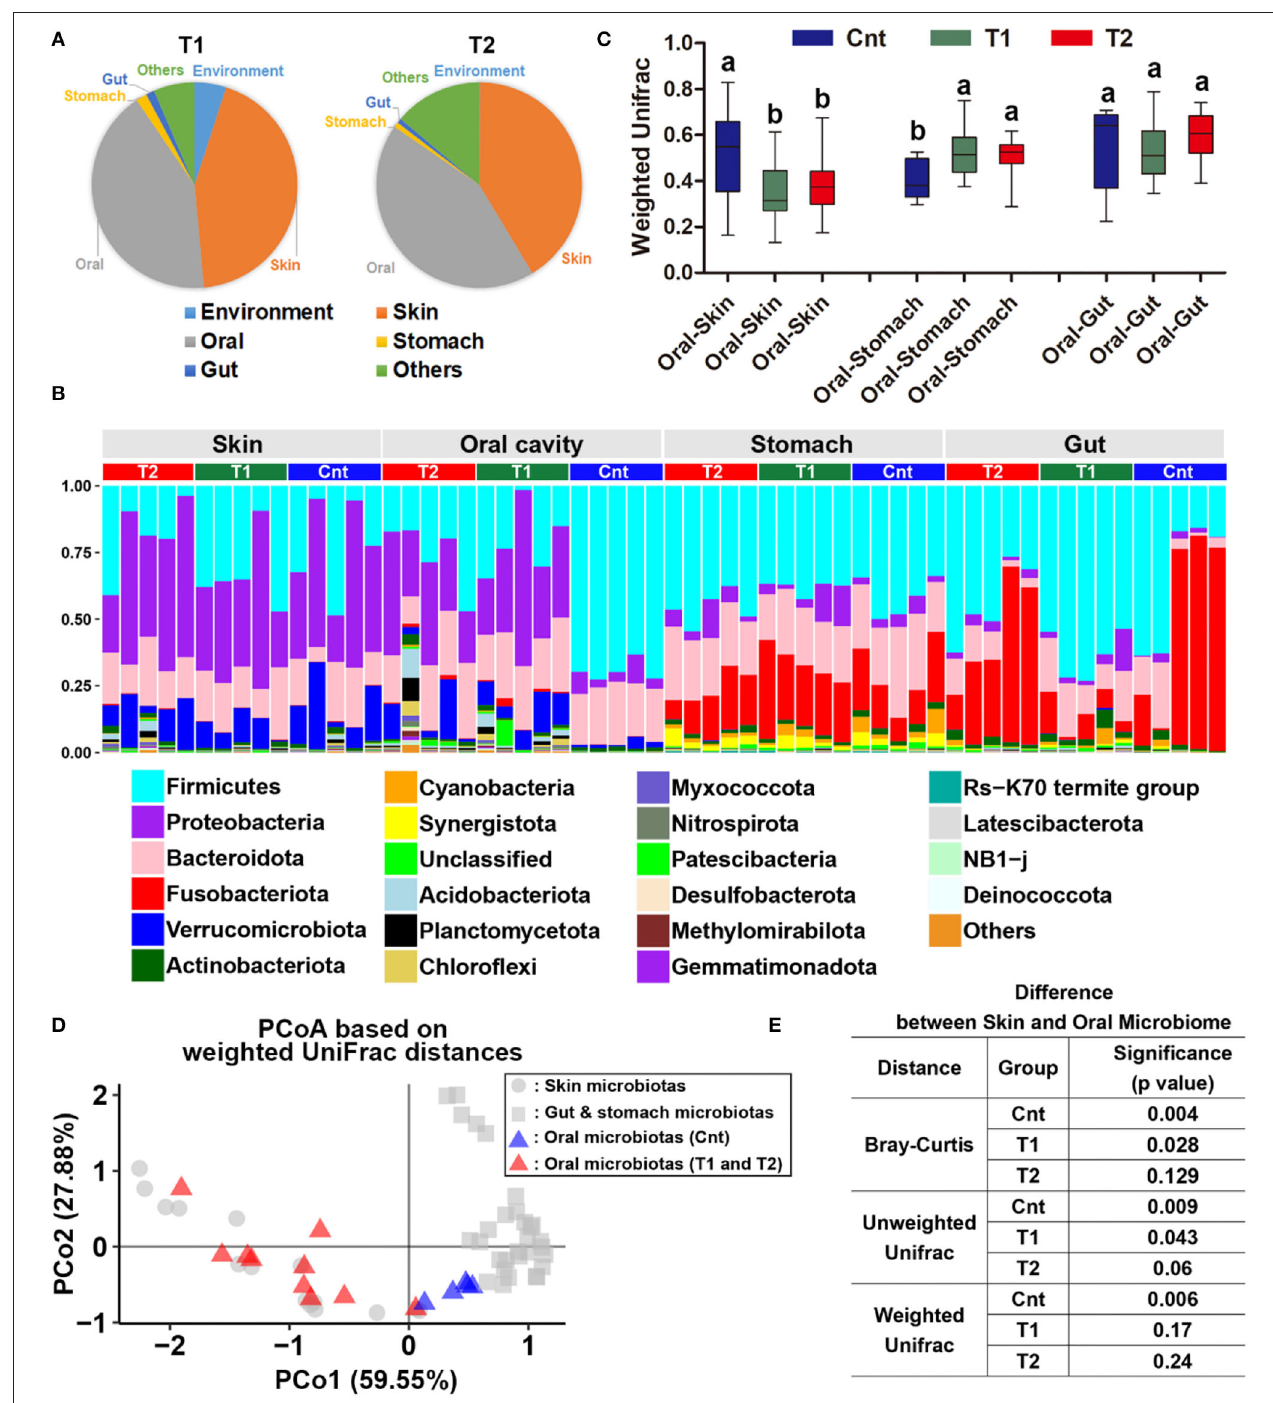
FIGURE 3 | Reorganization of the oral bacterial community. (A) Source-tracking analyses for the oral microbiota of larvae in treatment groups. The habitat/environment and original commensal microbiota were considered as the bacteria sources. Since the control group faced no variation of environmental conditions during treatment duration, their commensal microbiota was considered the original commensal microbiota of captive Andrias davidianus . (B) Variation of weighted UniFrac distances between oral and other commensal microbiota after treatment. Data are presented as means ± SE. Different superscripts denote significant differences between groups ( p < 0.05, one-way ANOVA and LSD post-hoc tests). (C) Bar plots represent the variation of microbiome similarity (at phylum level) between control, T1, and T2 groups. (D) A PCoA scatter plot presenting the variations of oral microbiota in the similarity to the skin, gut, and stomach microbiotas (Weighted UniFrac distance). (E) Results of